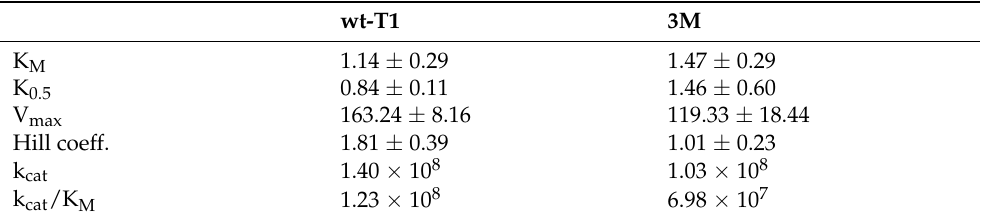
Table 1. Michaelis–Menten kinetics measuring the K M and k cat of the wt-T1 and 3M variant lipases.